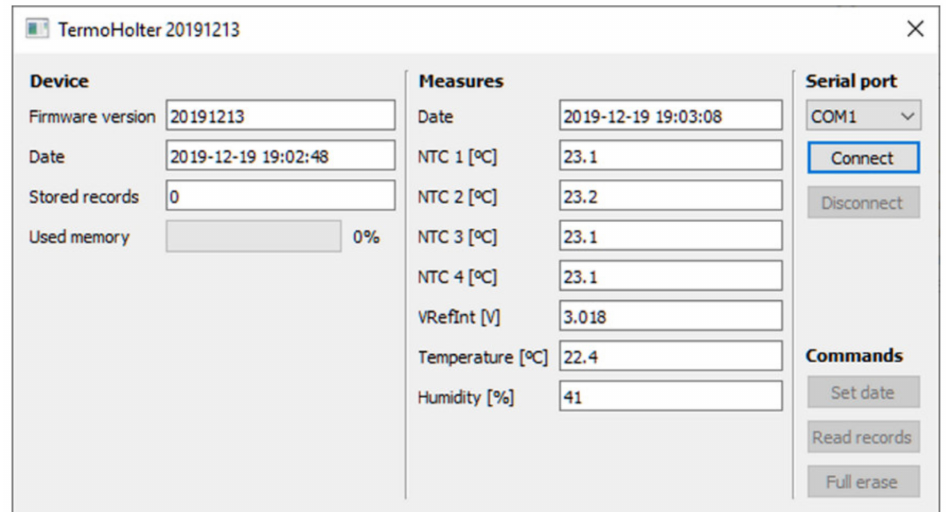
Figure A4. User dialog box with parameter information and configuration.